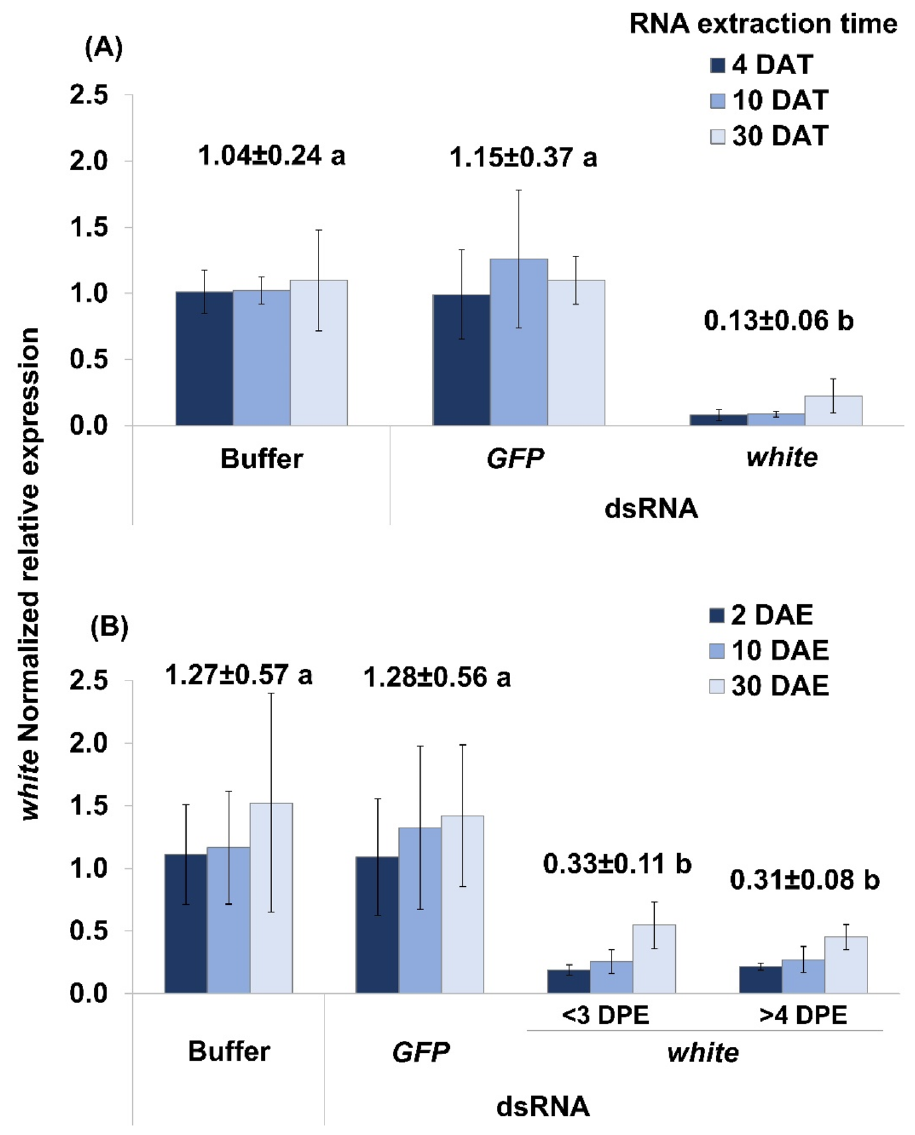
Figure 1. Transcript knockdown efficacy overtime of RNAi-based microinjection targeting the white gene of the SGSB. ( A ) SGSB adults had been treated at < 24 h after emergence. Significant white knockdown ( F ( 2,69 ) = 63.64 ; p < 0.0001 ) was observed in adults treated with white dsRNA relative to GFP dsRNA- and buffer-treated controls at 4, 10 and 30 days after treatment (DAT). ( B ) SGSB adults had been treated during fifth nymphal stage at either less than three or more than 4 days prior to adult emergence (DPE). Significant white knockdown ( F ( 3,92 ) = 17.61 ; p < 0.0001 ) was observed at 2, 10 and 30 days after adult emergence (DAE) in SGSB adults treated with white dsRNA either at < 3 DPE or > 4 DPE relative to GFP dsRNA- and buffer-treated controls. In each graph, bars discriminate white normalized relative expression means ± SE per time point and above bars show overall means ± SE per treatment across time. Treatment means followed by the same letter were not statistically different (Fisher’s LSD test, α =